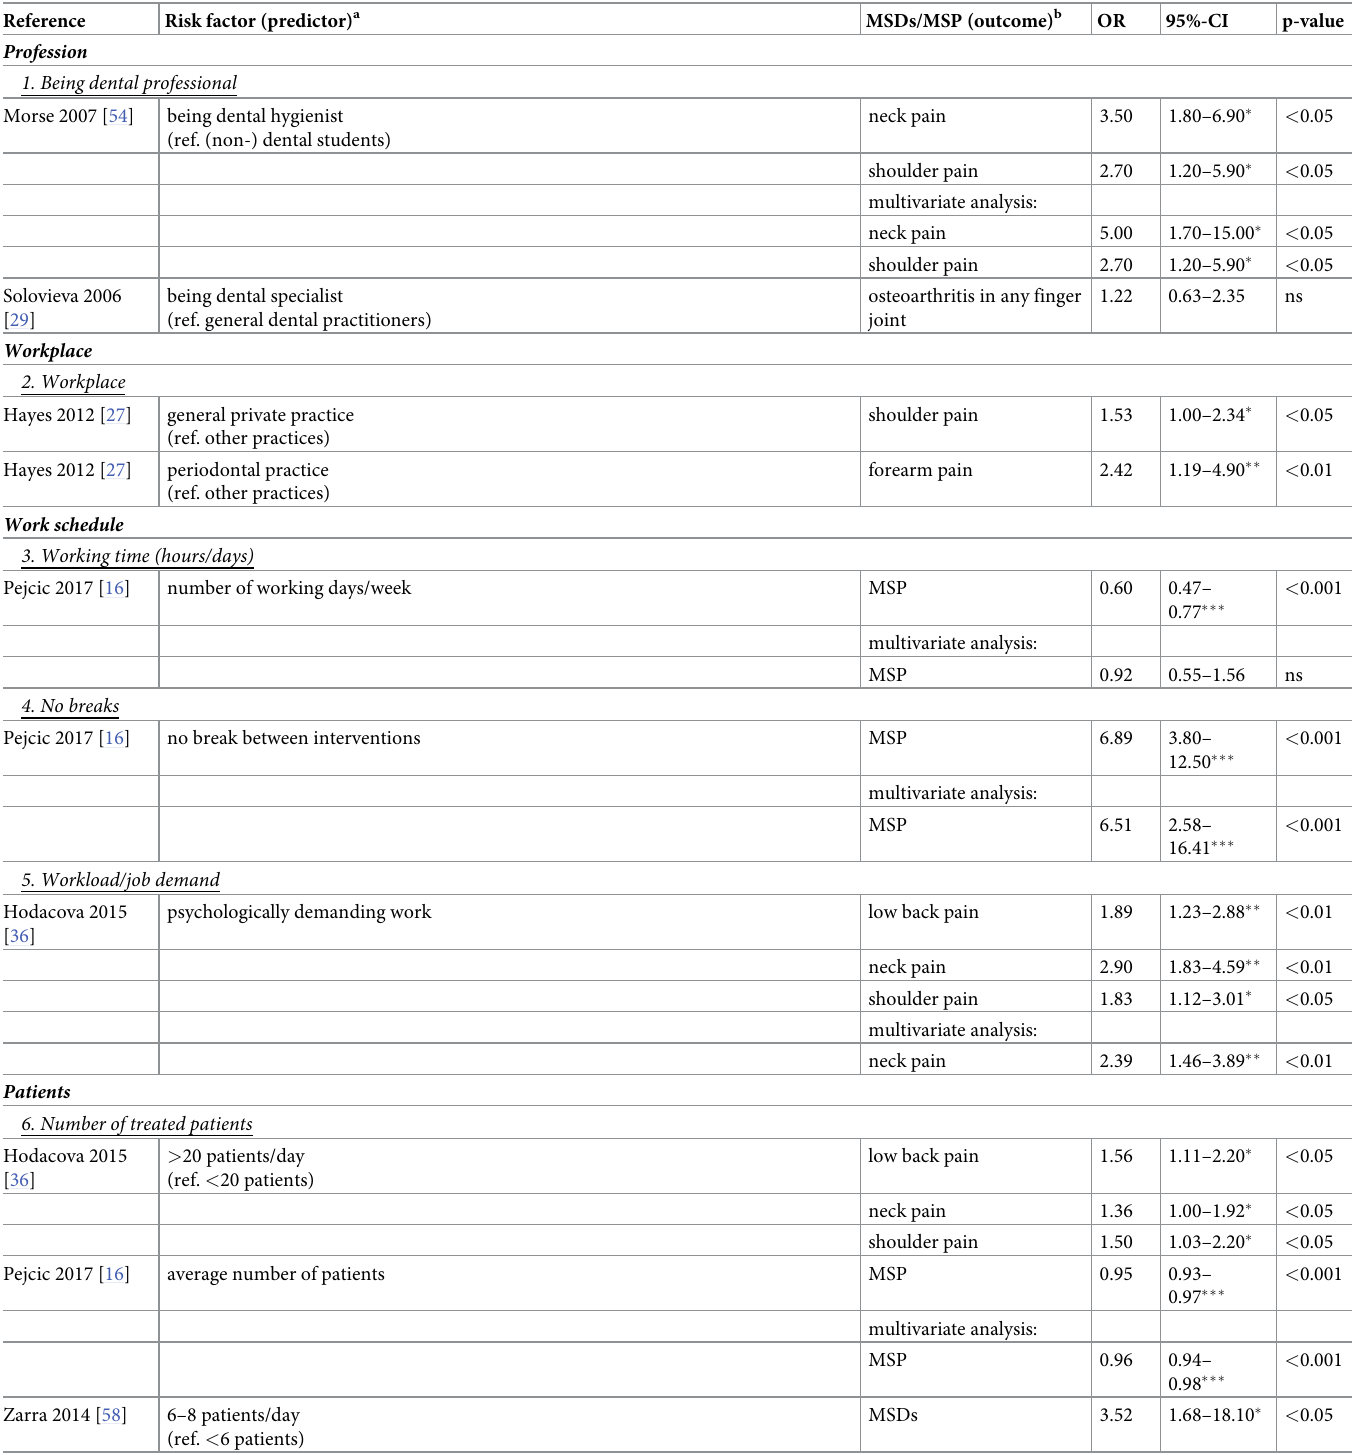
Table 5. Selected studies analyzing occupational risk factors for MSDs/MSP among dental professionals (n = 11).